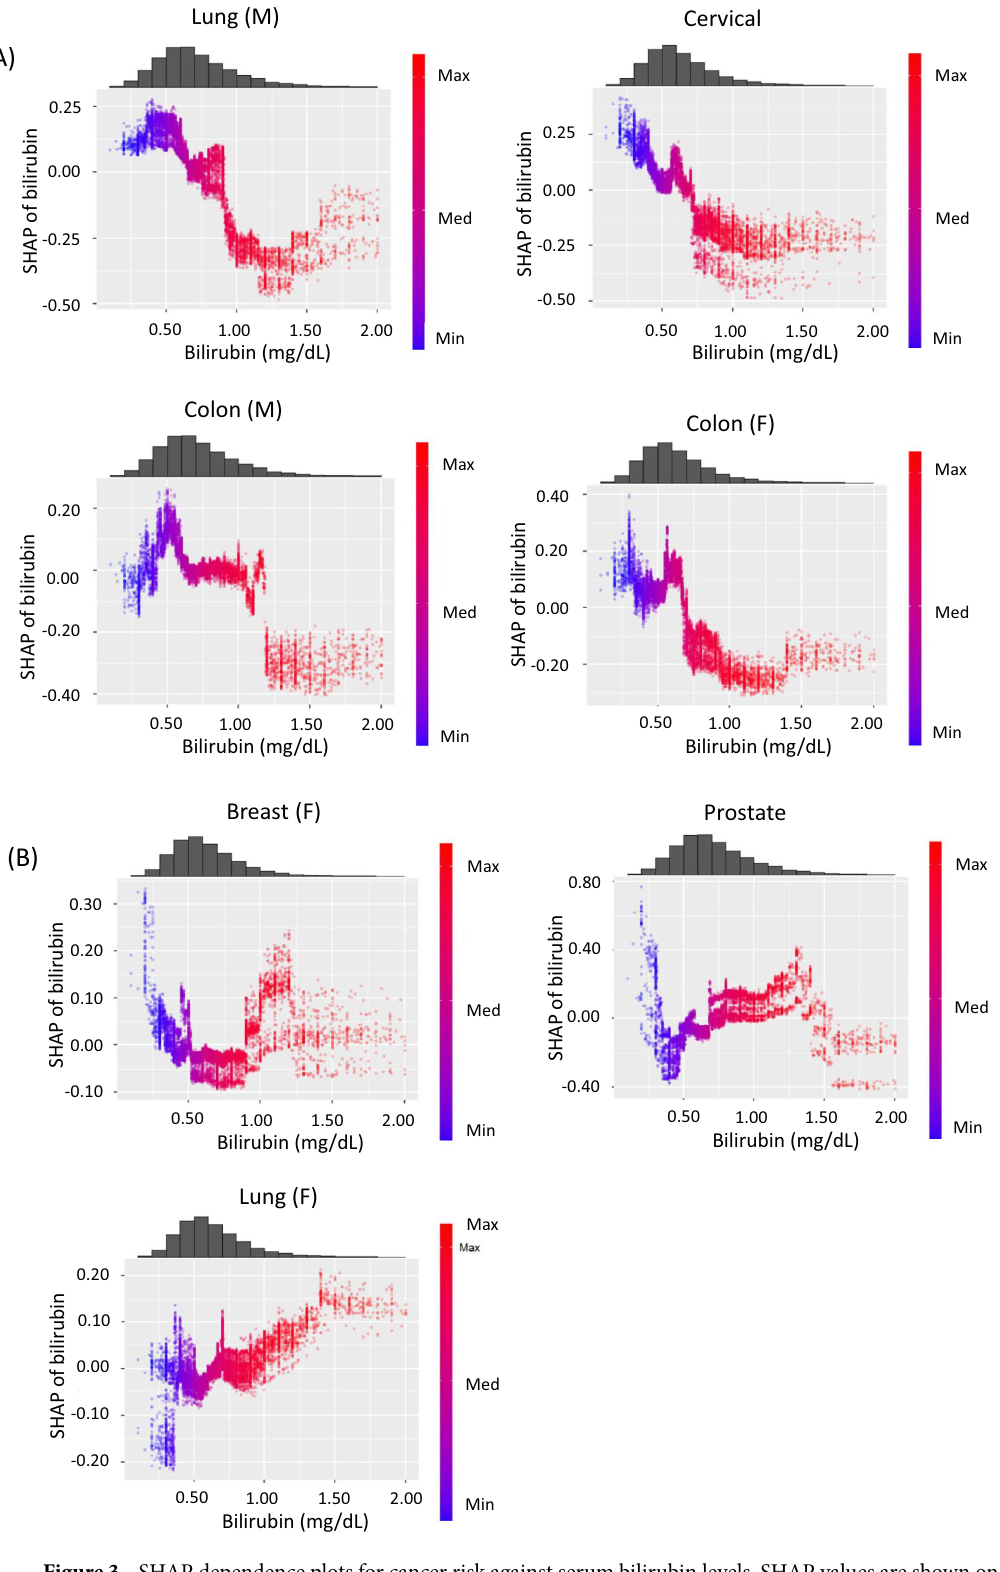
Figure 3. SHAP dependence plots for cancer risk against serum bilirubin levels. SHAP values are shown on the y-axis. ( A ) lung cancer in men (M), cervical cancer, colon cancer in men (M), and colon cancer in women (F). ( B ) breast cancer in women (F), prostate cancer, and lung cancer in women (F). ( C ) total all-cause death in men (M) and women (F). SHAP, SHapley Additive